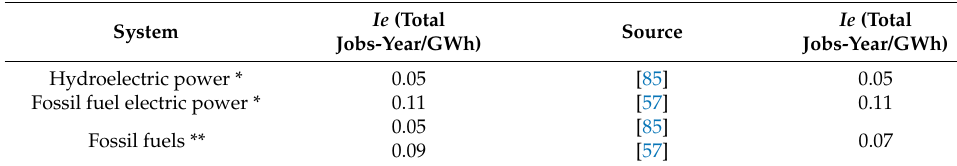
Table 20. The use of traditional energy resources.